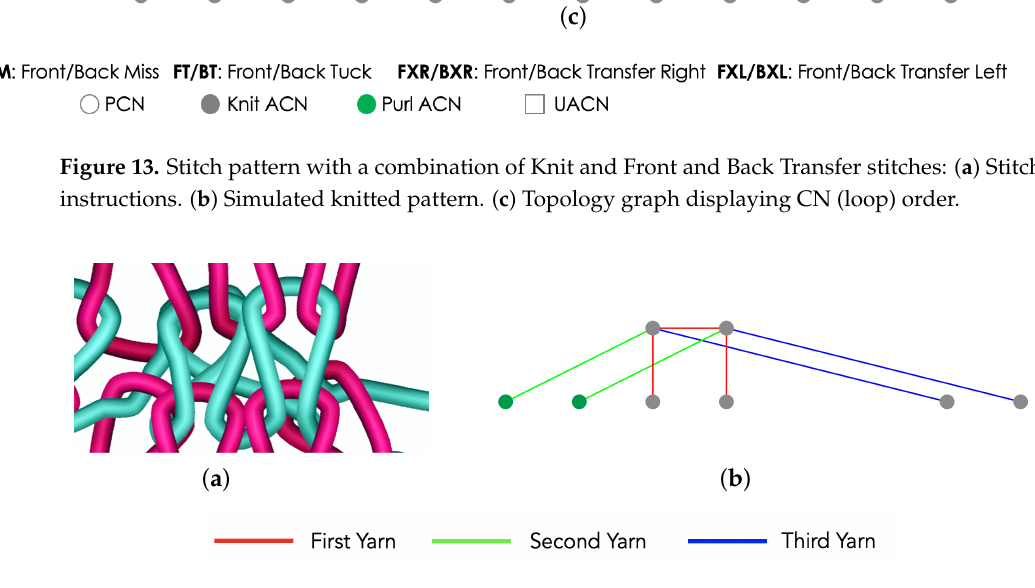
Figure 14. Yarn order zoom-in at location (4, 2) in the yarn topology graph of Figure 13: ( a ) Simulated knitted pattern. ( b ) Corresponding zoom-in topology graph.